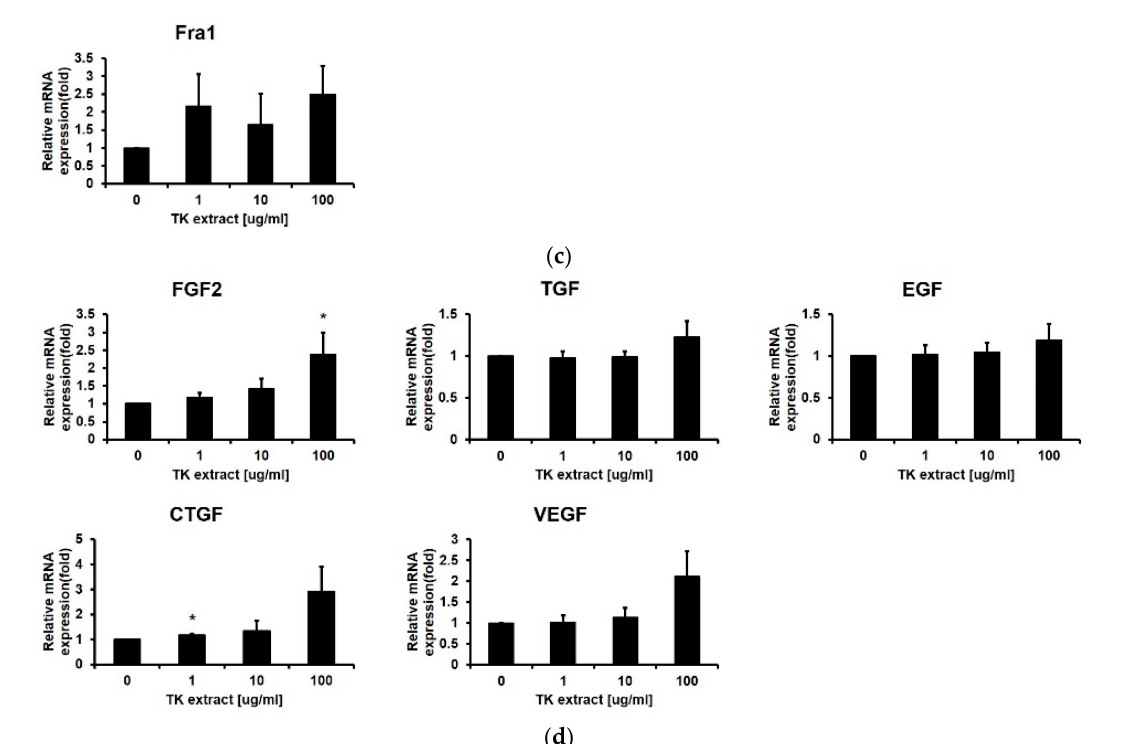
Figure 4. TK extract induced the mRNA expression of cell proliferation regulatory genes in HaCaT cells. HaCaT cells were treated with the indicated concentration of TK extract, and the total mRNA was used for qRT-PCR. The mRNA expression of ( a ) keratin genes (KRT), ( b ) cyclins and CDKs, ( c ) AP-1 transcription factors and Elk1, and ( d ) growth factors was analyzed. (*: p < 0.05, **: p < 0.01, ***: p < 0.001.)